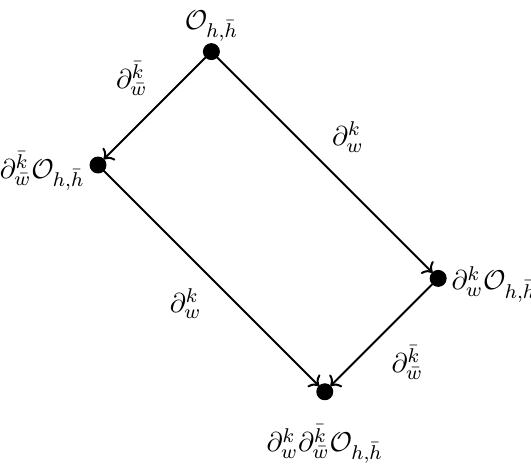
Figure 2 . Celestial diamond illustrating the nested submodule structure that appears at special values of the conformal dimension such that h = 1 − k